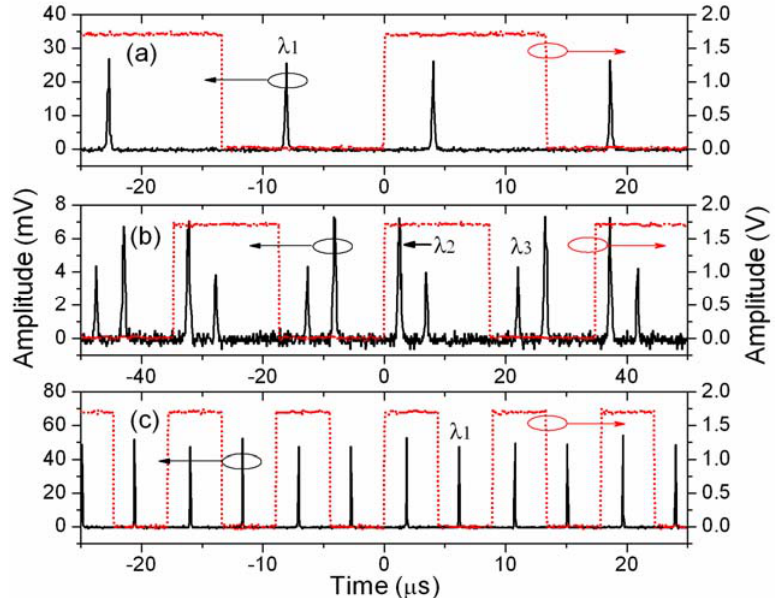
Figure 8. Time-domain spectra (solid curves) of the SL-FDML laser when the driving frequency is ( a ) 37.432 kHz, ( b ) 28.776 kHz, and ( c ) 112.30 kHz. Dotted curves show the trigger signal of the